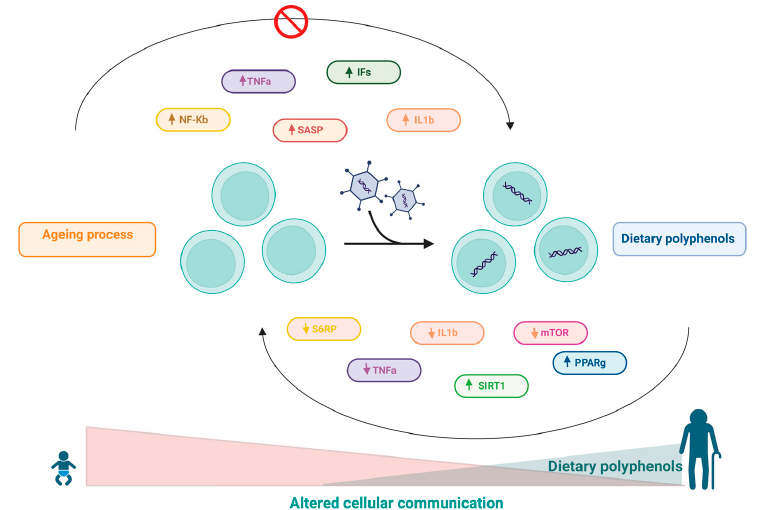
Figure 9. Inflammageing results from autonomous changes in cells, which involve changes in cell communication during the ageing process and includes accumulation of proinflammatory tissue damage. Apolyphenol-based diet can modulate the inflammatory cascade through the regulation of the SIRT1 pathway, resulting in a decrease in the inflammatory state.